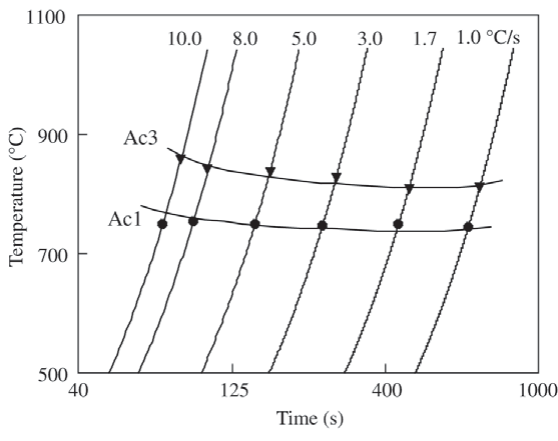
Figure 1. Continuous-heating-transformation diagram determined by